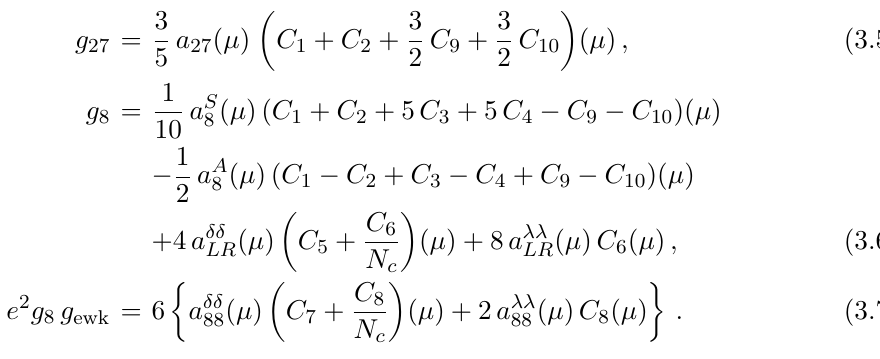
transforming as (27 , 1 ) , (8 , 1 ) and (8 , 8 ) , respectively. Here, λ ≡ 1 L R L R L R projects onto the ¯ s → ¯ d transition and Q = 1 diag(2 , − 1 − 1) is the quark charge matrix. 3 Particularizing the tensor sources in eqs. (2.4) and (2.25) to the SM ∆ S = 1 Lagrangian (3.1) and projecting over the different chiral-symmetry components, using eqs. (2.22), (2.23), (2.24), (2.29) and (2.30), one easily finds the expression of the